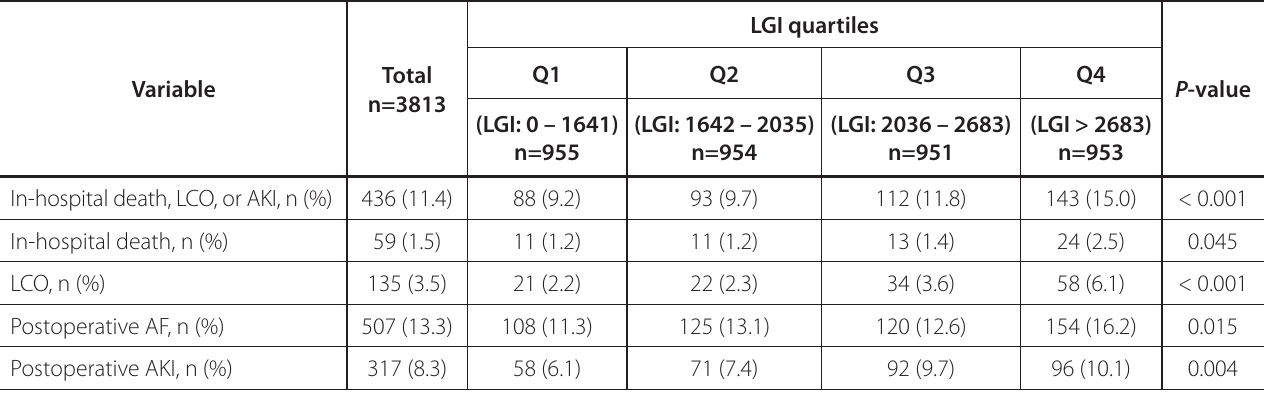
Table 3 . Primary and secondary outcomes according to LGI.